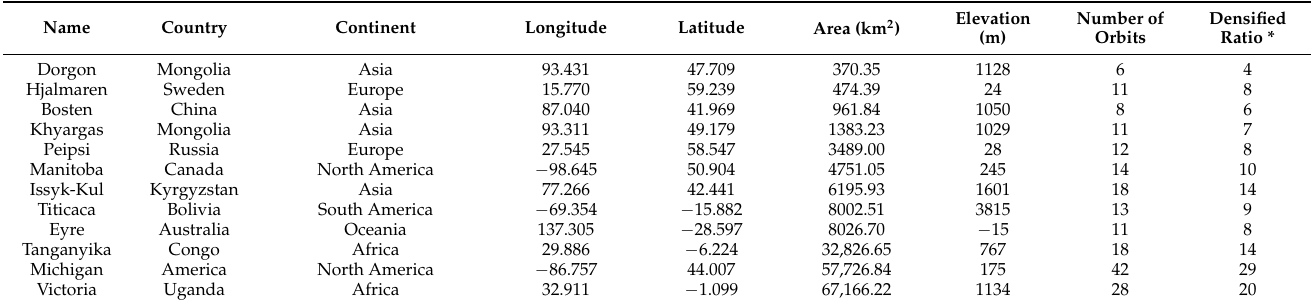
Table 2. Summary of sample lakes and assessment of adjustment results.